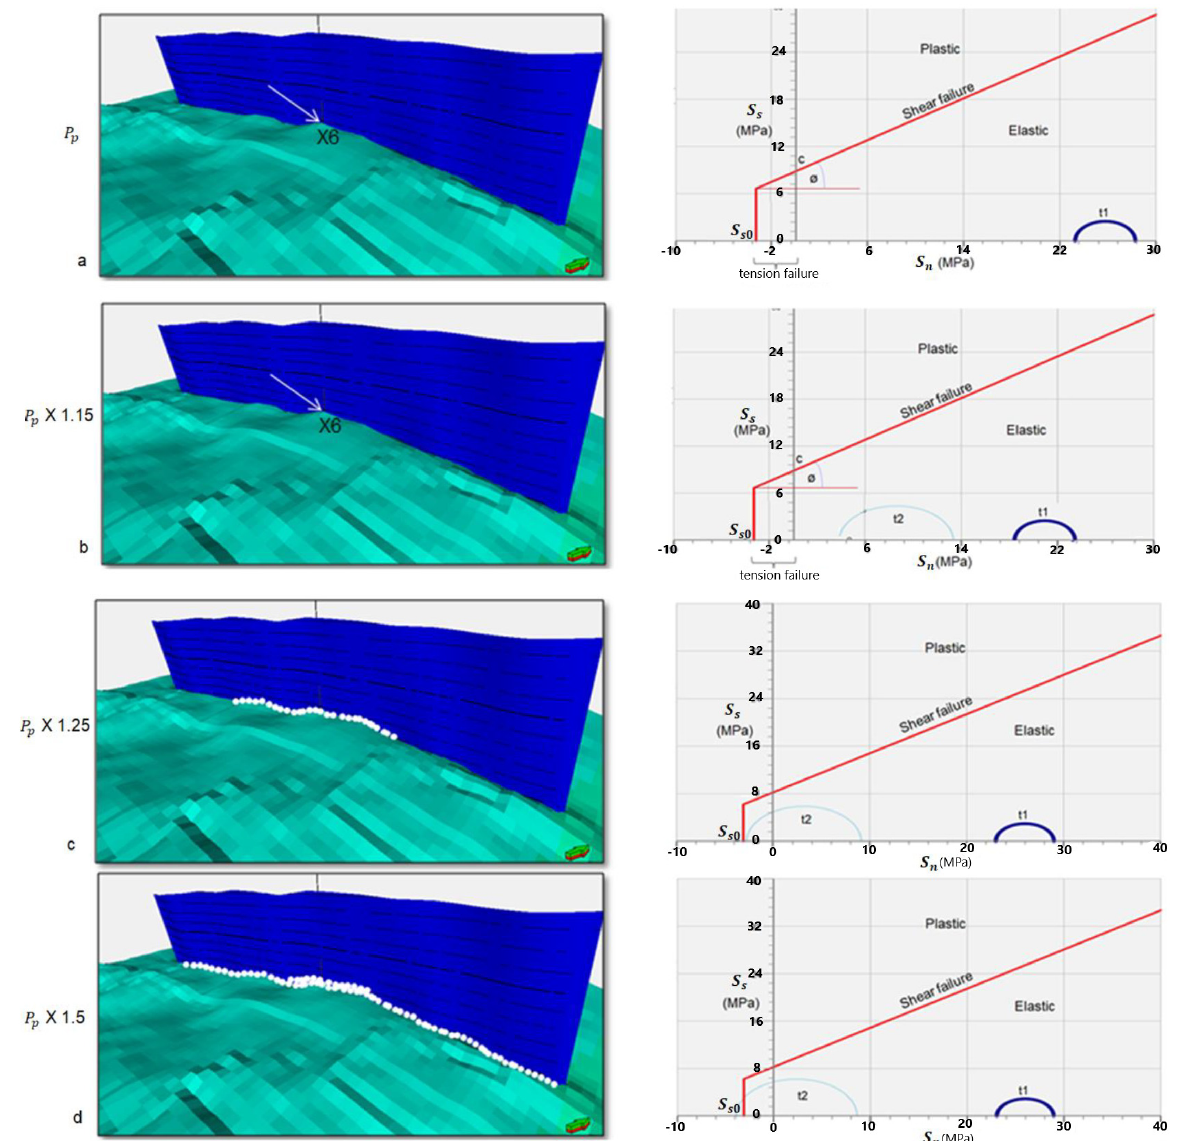
Figure 15. The computation of fault reactivation for initial pore pressure multiplied by a factor of 1 ( a ), 1.15 ( b ), 1.25 ( c ), and 1.5 ( d ) is shown on the left side. White boxes show the cells with stress states exceeding the failure criterion (arrows show northward direction). On the right side of the figure are the shear stress S s vs. normal stress S n diagrams, showing the Mohr–Coulomb failure criterion at the well X6 location (which is nearest the main fault of the reservoir). Time steps t1 and t2 correspond to the starting (1 January 2020) and fi nal (1 January 2021) time steps of the tested cases, respectively. The increase in pore pressure leads to a decrease in e ff ective stresses, causing the cor- responding Mohr circle to shift to the left. If the failure line is fi nally touched, plastic straining and—in case of a fault zone—fault reactivation occur.